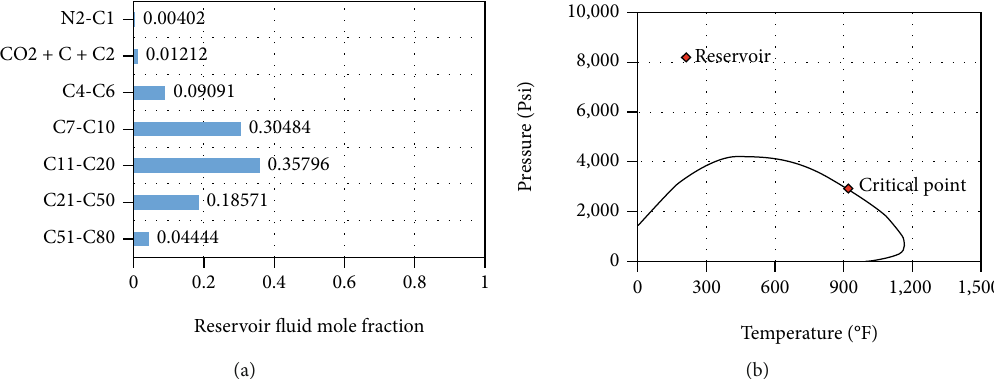
Figure 5: Reservoir fl uid properties of: (a) composition and (b) P-T diagram with marked initial reservoir condition and critical